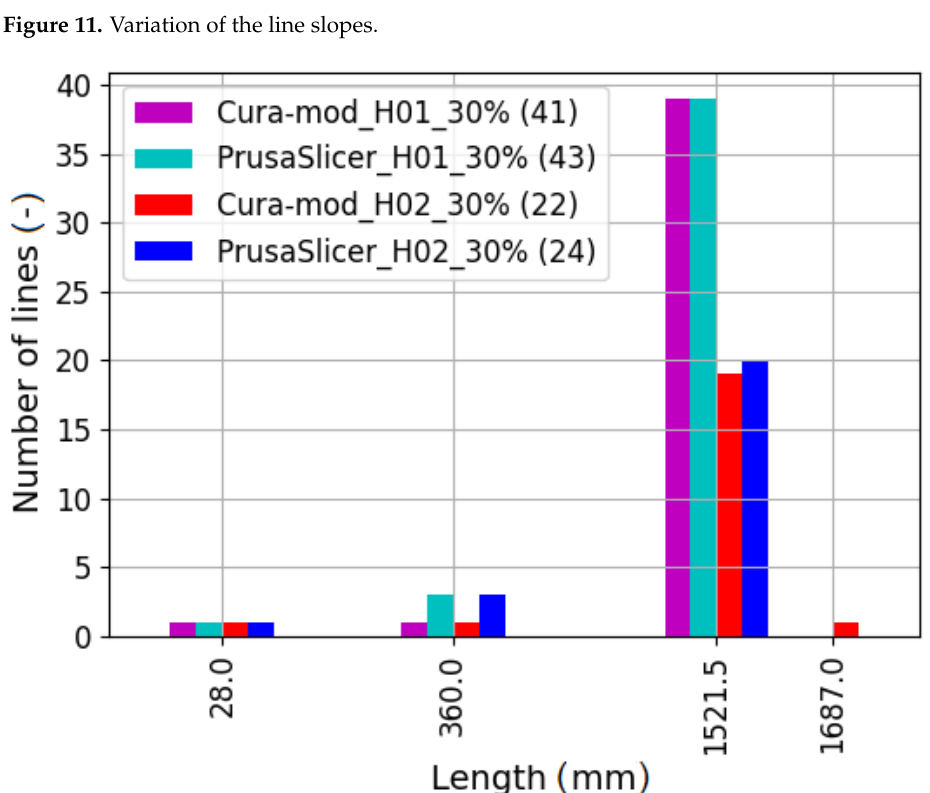
Figure 12. Total length of lines for continuous